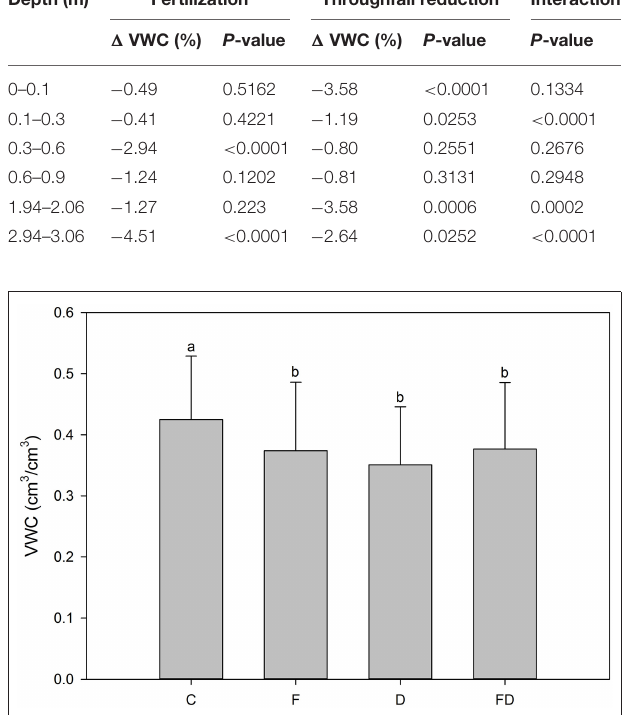
TABLE 1 | Treatment effects of fertilization, throughfall reduction, and their interaction ( n = 4) on soil volumetric water content (VWC), and %VWC change. Depth (m)